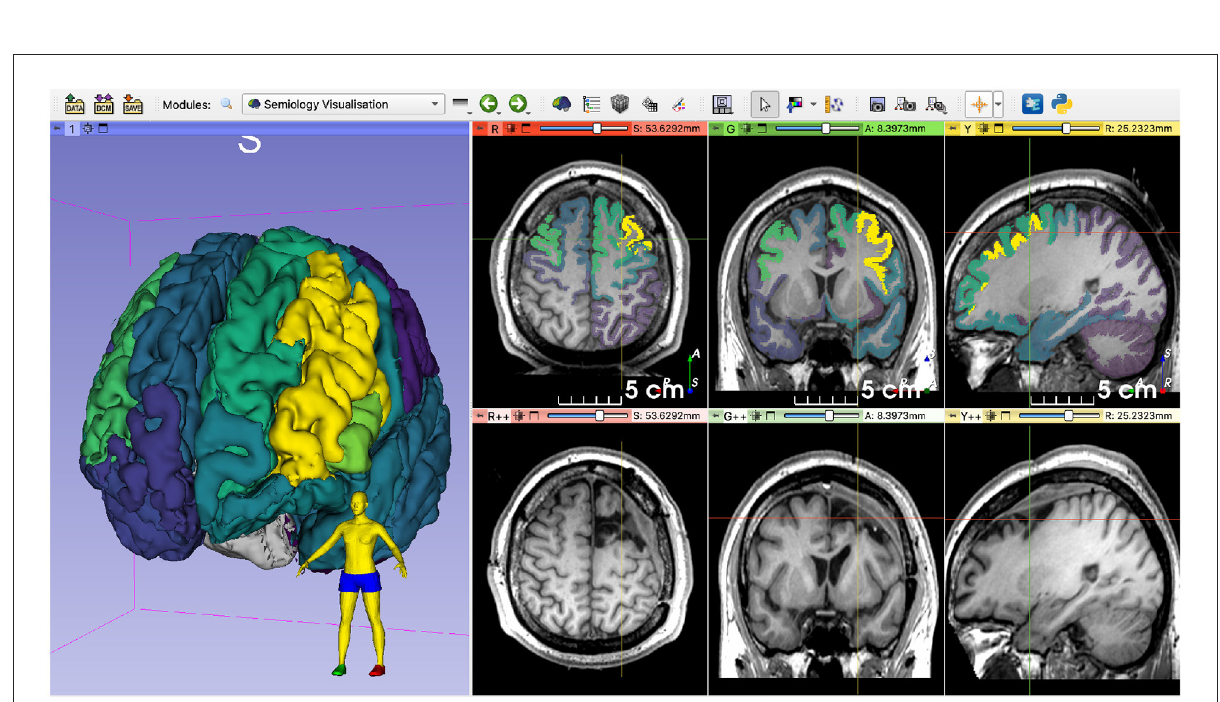
FIGURE8 Qualitative comparison of the EZ probability map and the postoperative MRI. Note the overlap between the highlighted structures and the resection cavity. The images were rigidly registered, and the crosshairs are centered on approximately the same region. The patient became seizure-free after resective